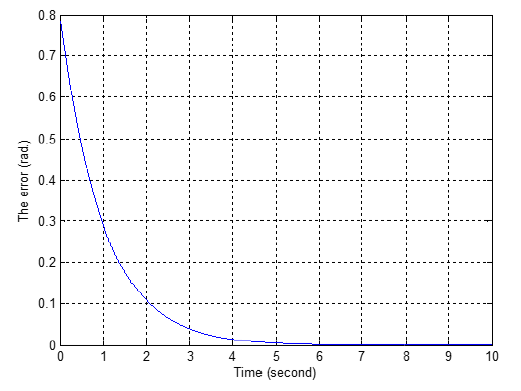
Fig. 15. The plot of sliding variable S vs. time of the . The plot of sliding variable S vs. time of the CSMC.